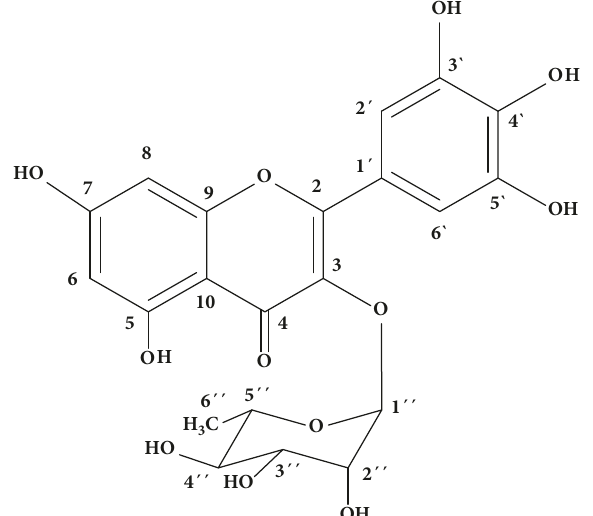
Figure 7: Structure of myricetin-3-O-rhamnoside compound iso- lated from the fraction F4.